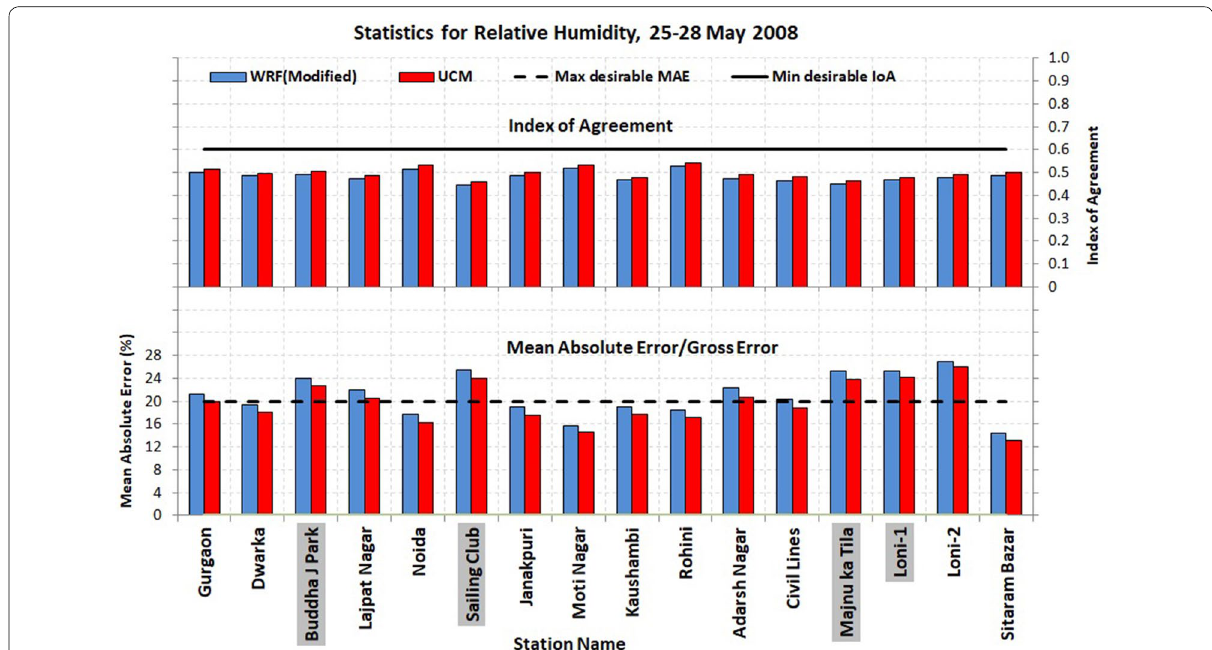
Fig. 5 Index of agreement (top) and mean absolute error (bottom) for some individual sites for relative humidity. Shaded names indicate non-urban stations